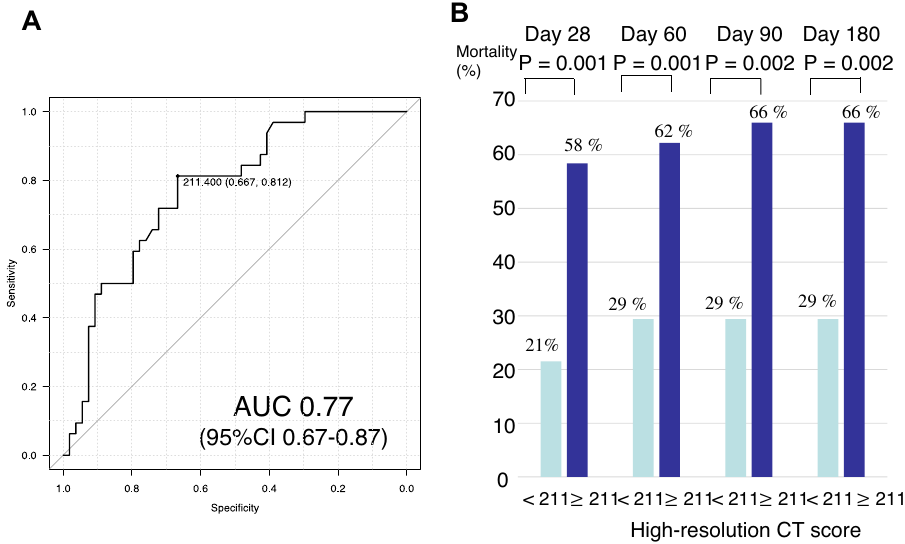
Figure 3. ( A ) Receiver operator characteristic (ROC) curve of the predictive value of the high-resolution CT score for late death (≥ 7 days from diagnosis). The ROC curve yielded an optimal cutoff value of the HRCT score of 211, which was determined by the Youden Index for the prediction of death from day 7 to day 180, with 81% sensitivity and 67% specificity (AUC, 0.771; 95%CI, 0.671–0.872). ( B ) Each mortality rate was compared between the optimal cutoff value of the high-resolution CT score. The mortality rate of patients with HRCT scores less than 211 ranged between 20 and 30% at any time point; the rate of those with an HRCT score of 211 or greater ranged between 58 and 66%. Statistical differences were noted between the 2 groups at all time